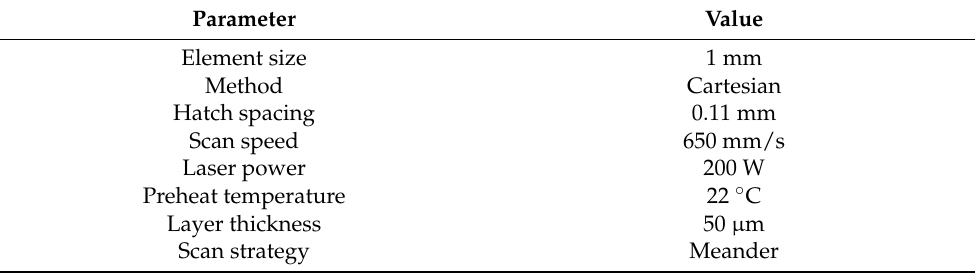
Table 1. Process parameter for input data in ANSYS Additive Suite